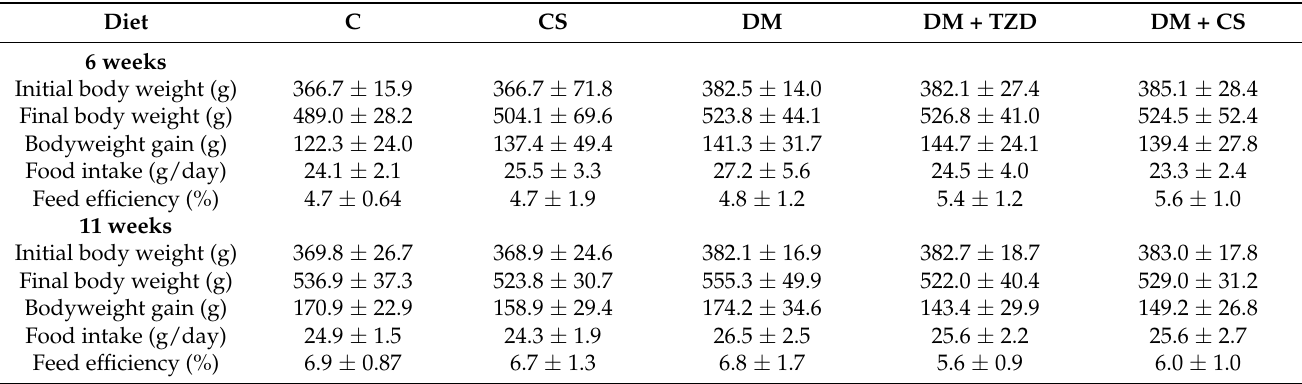
Table 1. The changes of body weight and food intake in SD rats fed different experimental diets for 6 and 11 weeks.